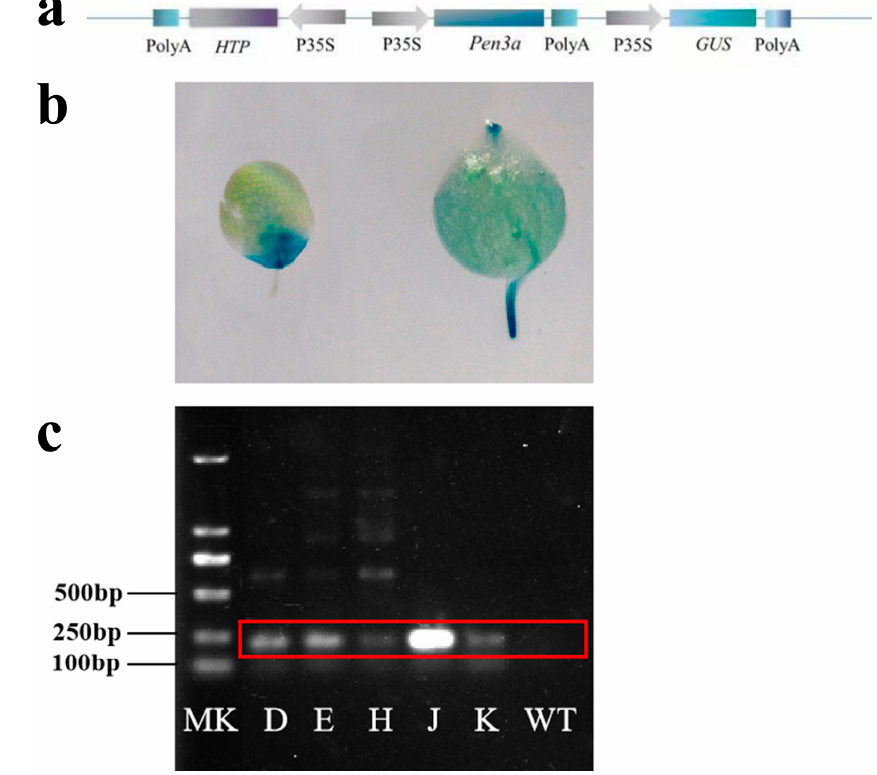
Figure 1. ( a ) T-DNA schematic representation of the fi nal plasmid pCAMBIA-1301-Pen3a. Poly